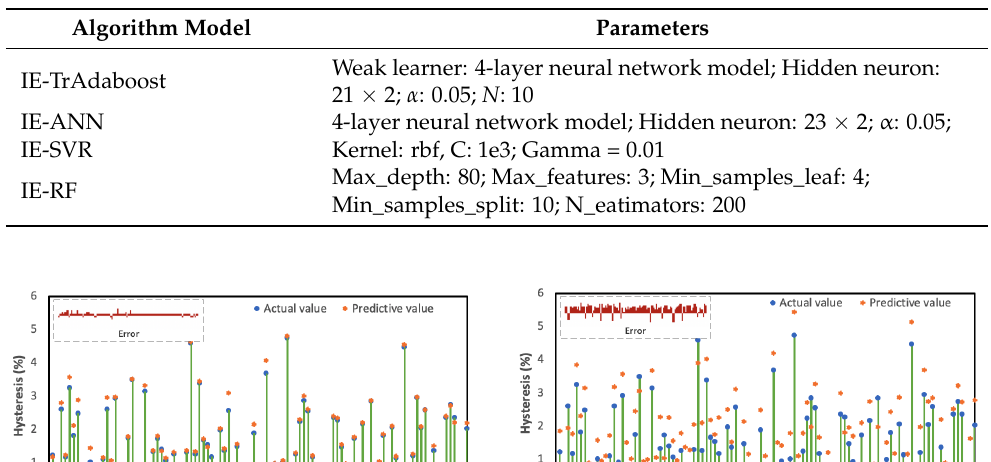
Table 6. The parameters of algorithm model.